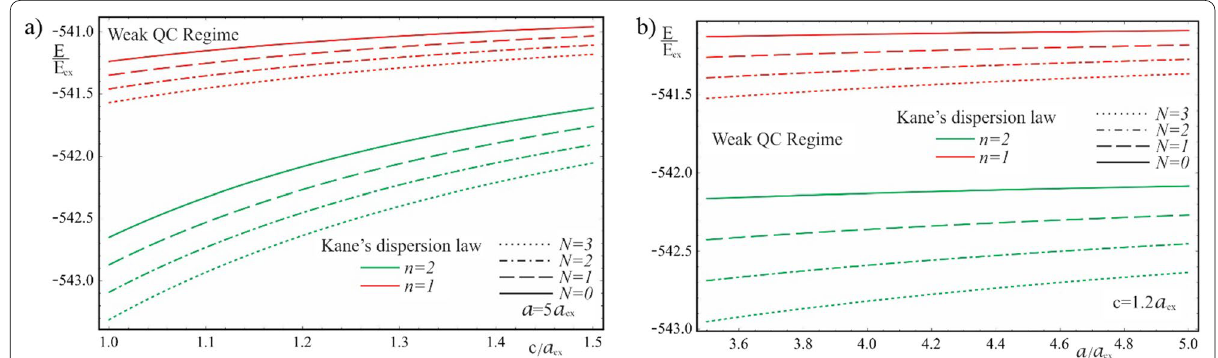
Fig. 9 The dependences of the exciton energy on ( a ) the minor semiaxis c at the fixed value of the major semiaxis a , ( b ) the major semiaxis a at the fixed value of the minor semiaxis c (Kane’s dispersion law)